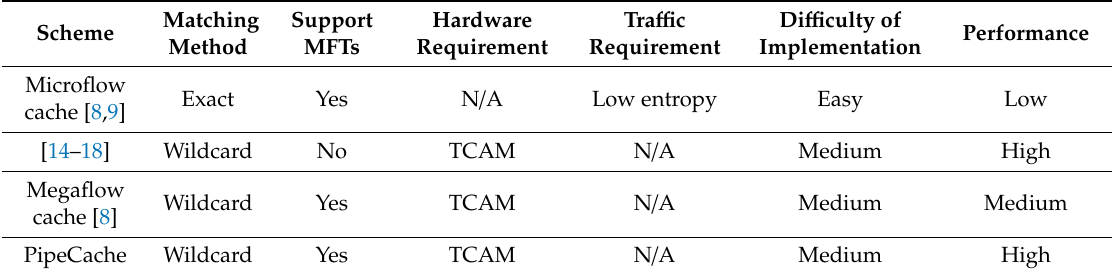
Table 2. Comparison between existing solutions and PipeCache.